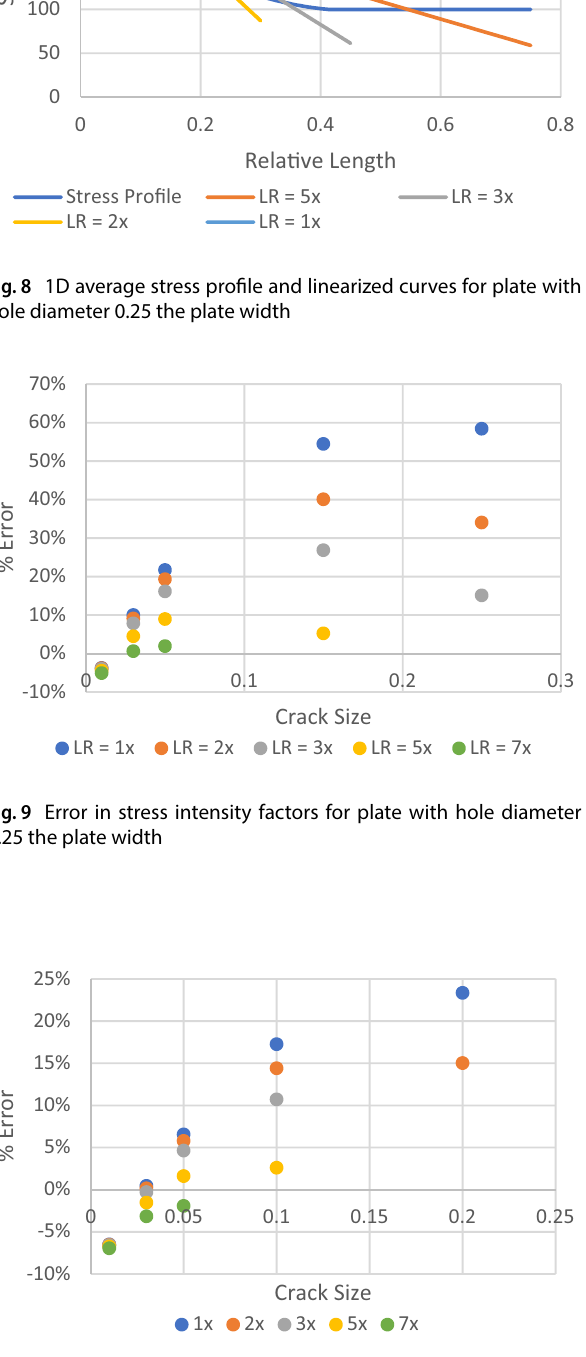
Fig. 10 Error in stress intensity factors for plate with hole diameter 0.5 the plate